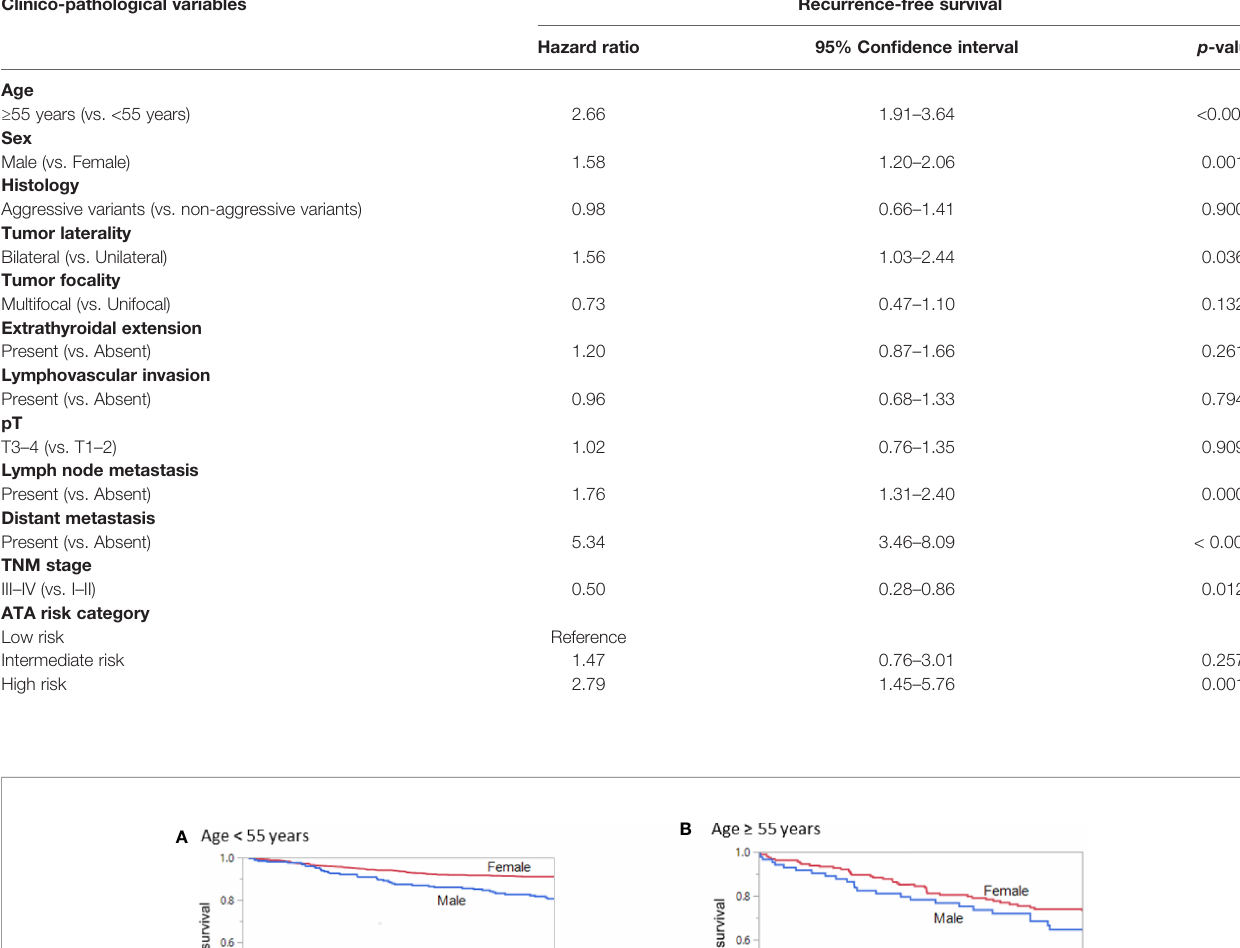
TABLE 3 | Multivariate analysis using Cox proportional hazard model for recurrence-free survival.